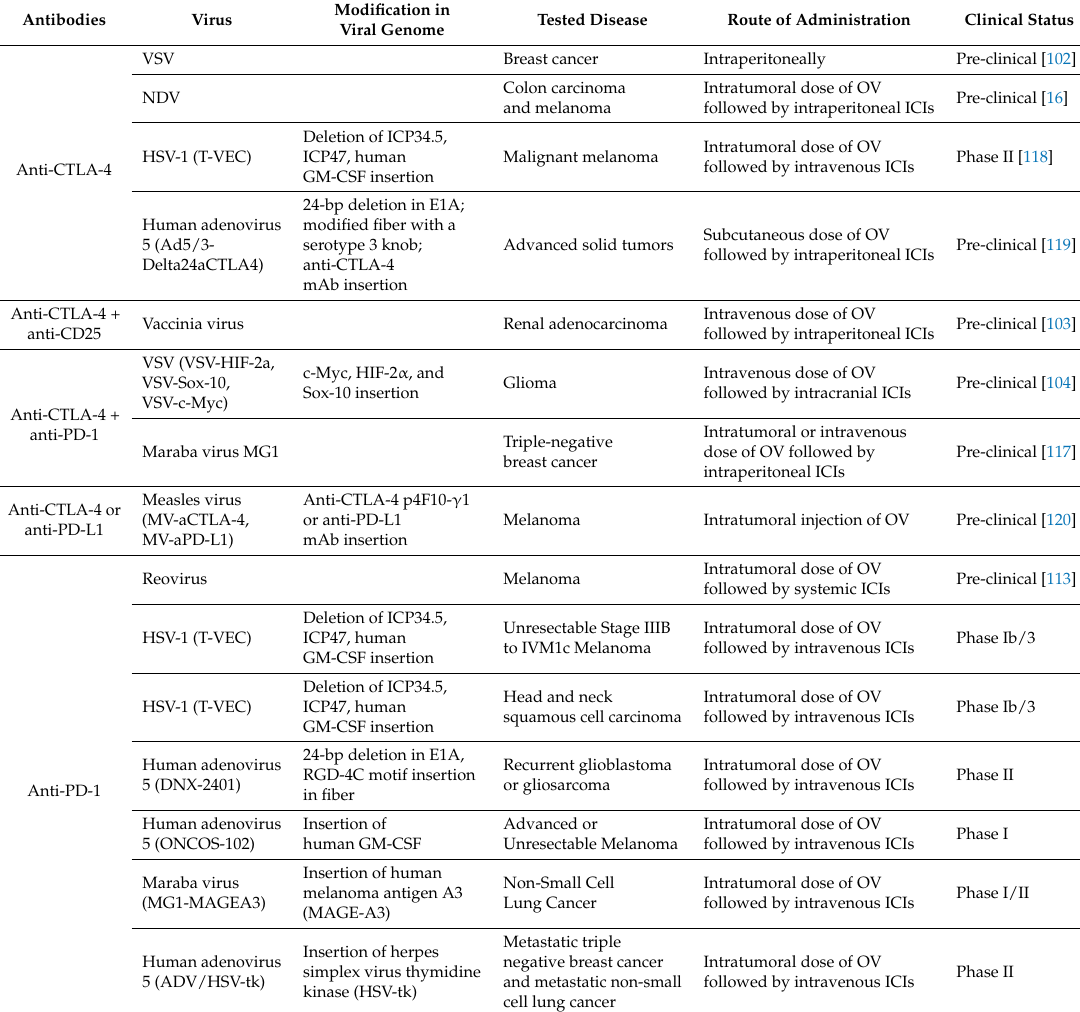
Table 2. Combinational therapies with ICIs and